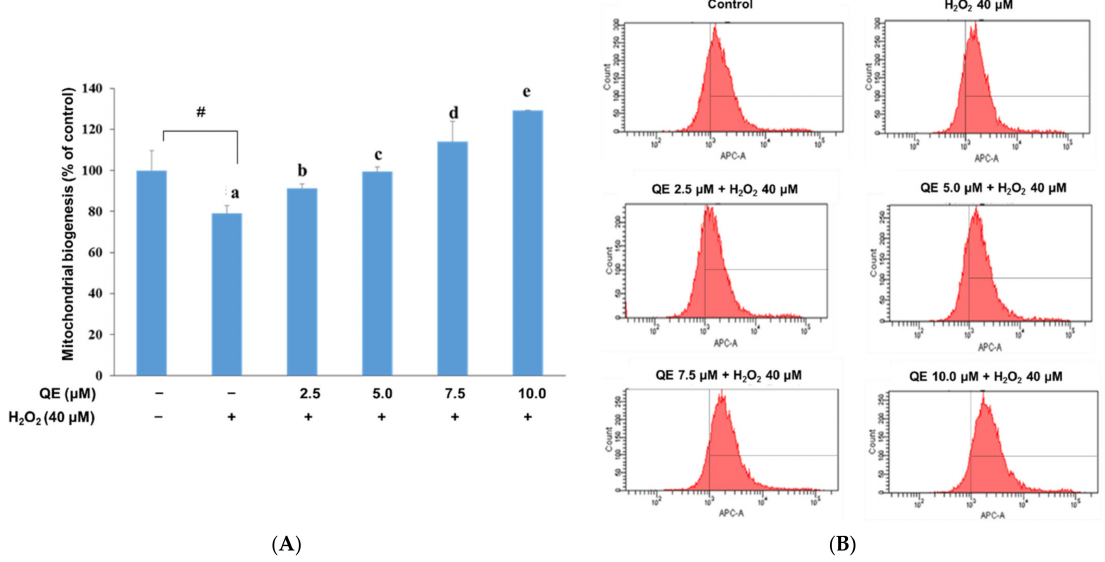
Figure 2. Effects of quercetin on mitochondrial biogenesis following H 2 O 2 -induced oxidative stress in the SH-SY5Y cells. ( A ) Quantitative results of mitochondrial biogenesis in each group according to ( B ). ( B ) Representative profiles of the mitochondrial biogenesis detected by flow cytometry using Mito Tracker Red FM. The SH-SY5Y cells were incubated with 40 µ M H 2 O 2 for 24 h after the addition of 2.5, 5.0, 7.5, and 10.0 µ M quercetin for 24 h. Data were presented as mean ± SD. # Data are analyzed using an independent t -test and are significantly different from the control group. Bars of 0, 2.5, 5.0, 7.5, and 10.0 µ M quercetin with different letters significantly differ. Statistical analysis was performed using a one-way ANOVA, followed by a least significant difference post hoc test ( n =